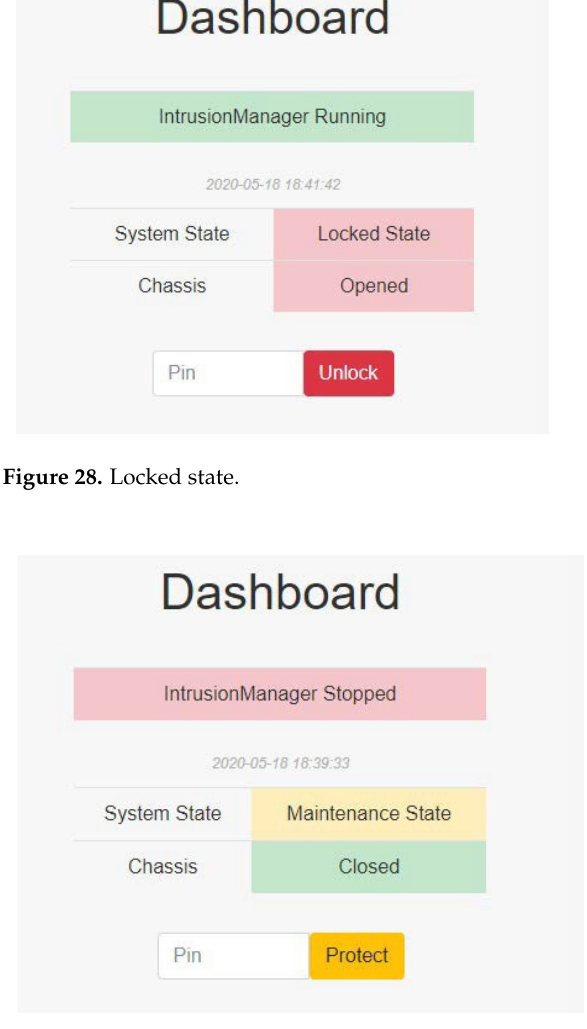
Figure 27. Operating state.